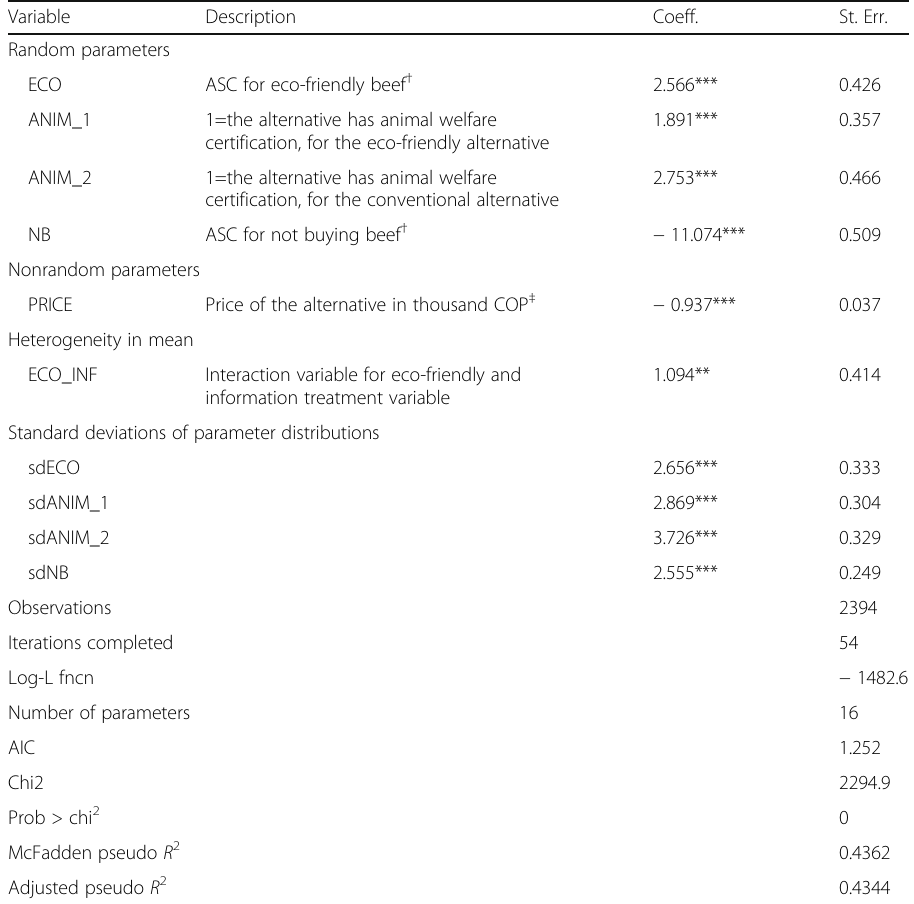
Table 5 Results — mixed logit